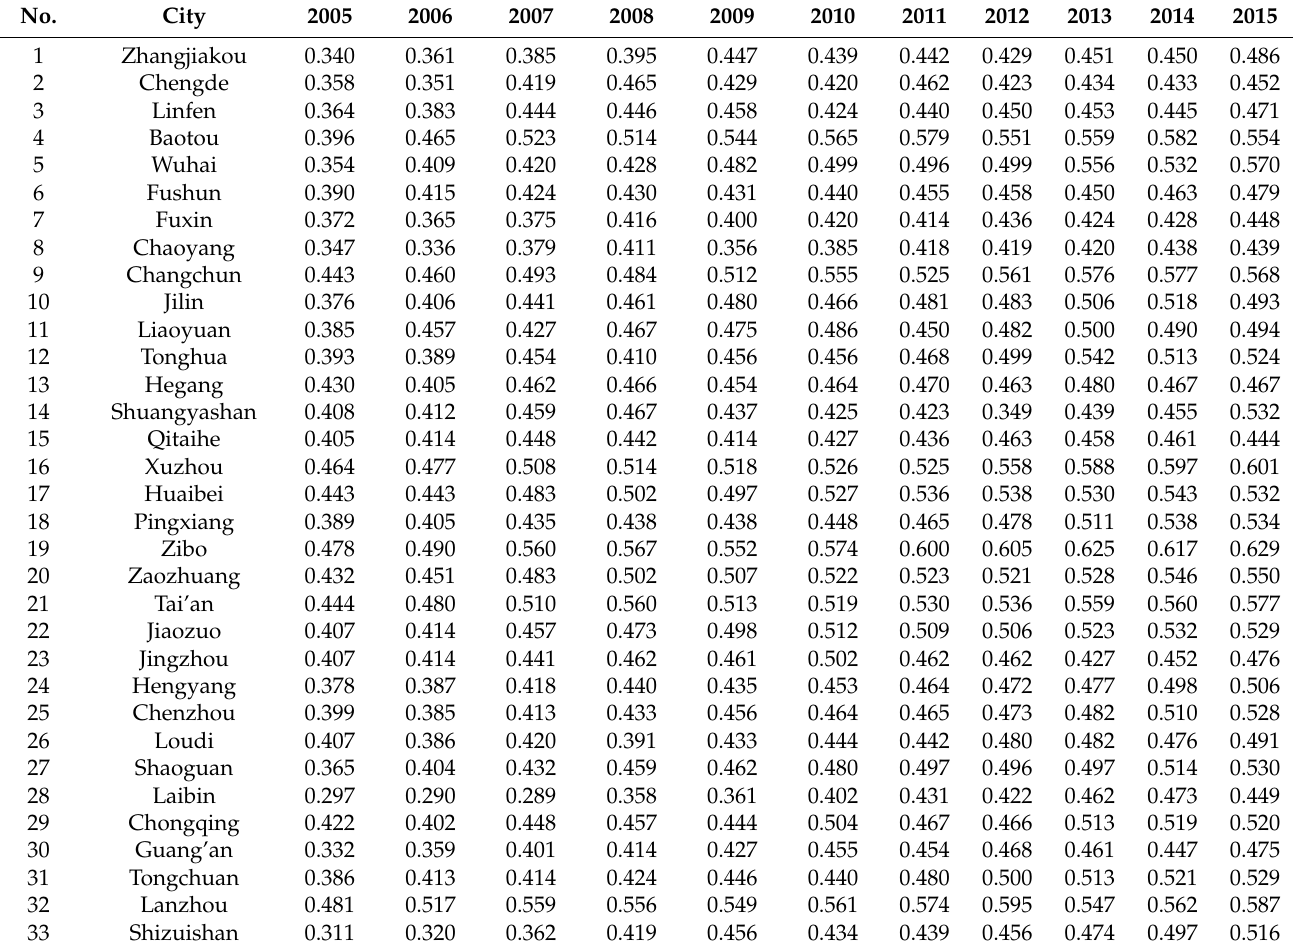
Table 10. Evaluation scores of green development of coal-resource-exhausted cities from 2005 to